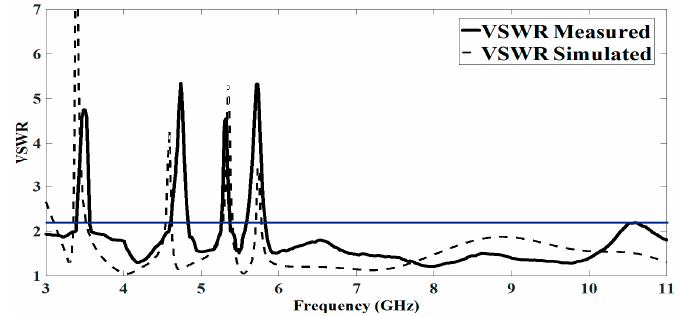
Figure 10. Simulated vs. measured VSWR of the proposed antenna.